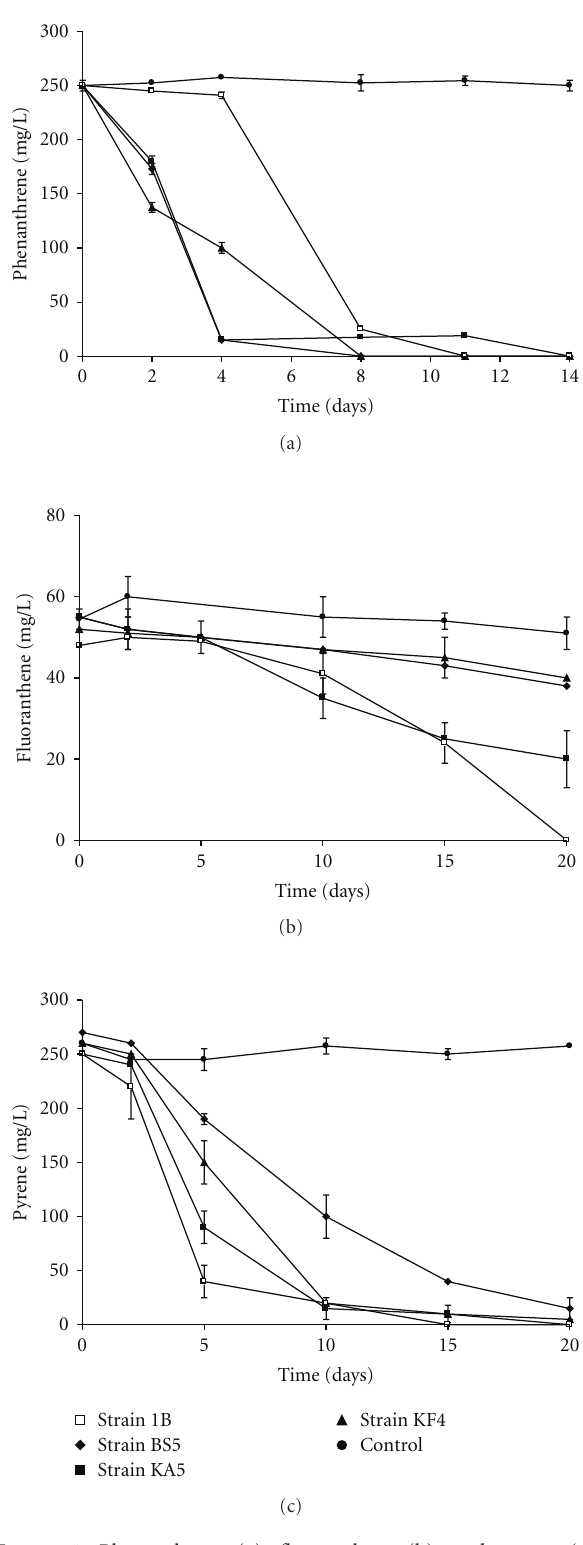
Figure 1: Phenanthrene (a), fluoranthene (b), and pyrene (c) degradation by Mycobacterium sp. strains 1B (white square), BS5 (black diamond), KA5, (black square), and KF4 (black triangle). The change in PAH concentration in mercuric chloride killed controls is also shown (black circle). Data points represent the mean and standard deviation of three replicates for each time